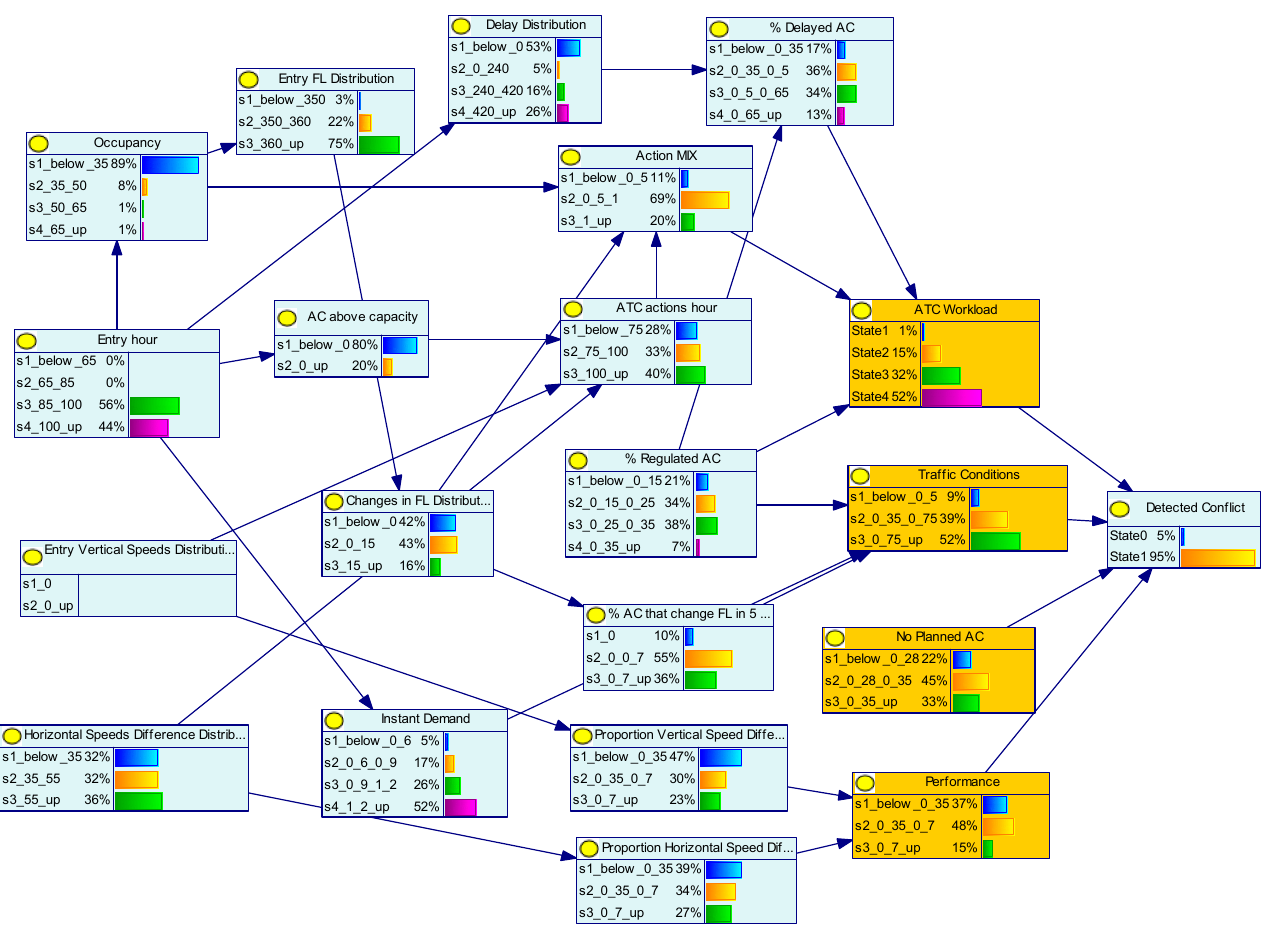
Figure 7. Forward analysis LECMSAN greater than 90% of its capacity.